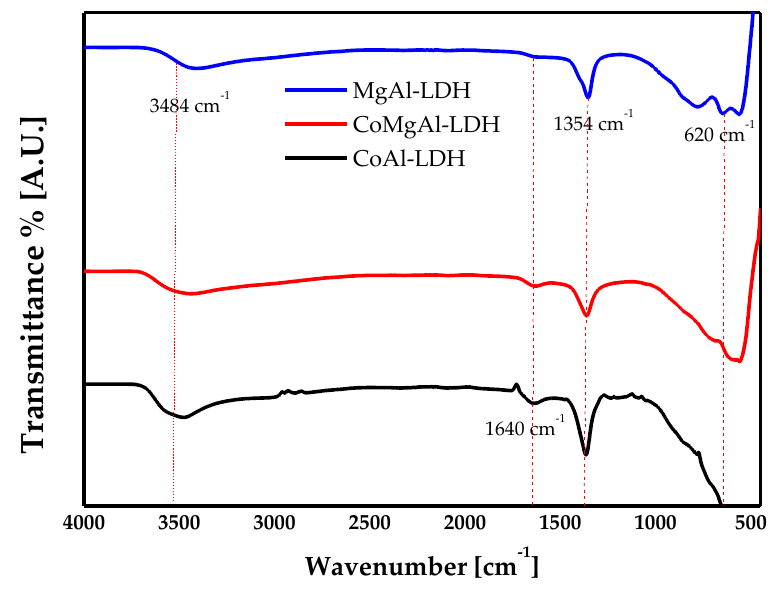
Figure 1. Fourier-transform infrared (FTIR) spectra of all the investigated samples.